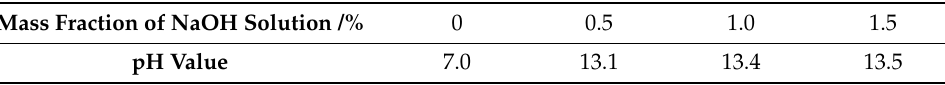
Table 3. The pH values of various mass fractions of NaOH solutions. Mass Fraction of NaOH Solution /%